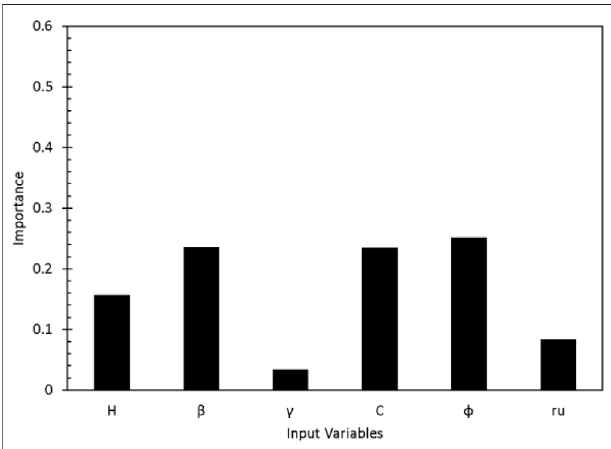
FIGURE 7 | Importance of a Feature for Function